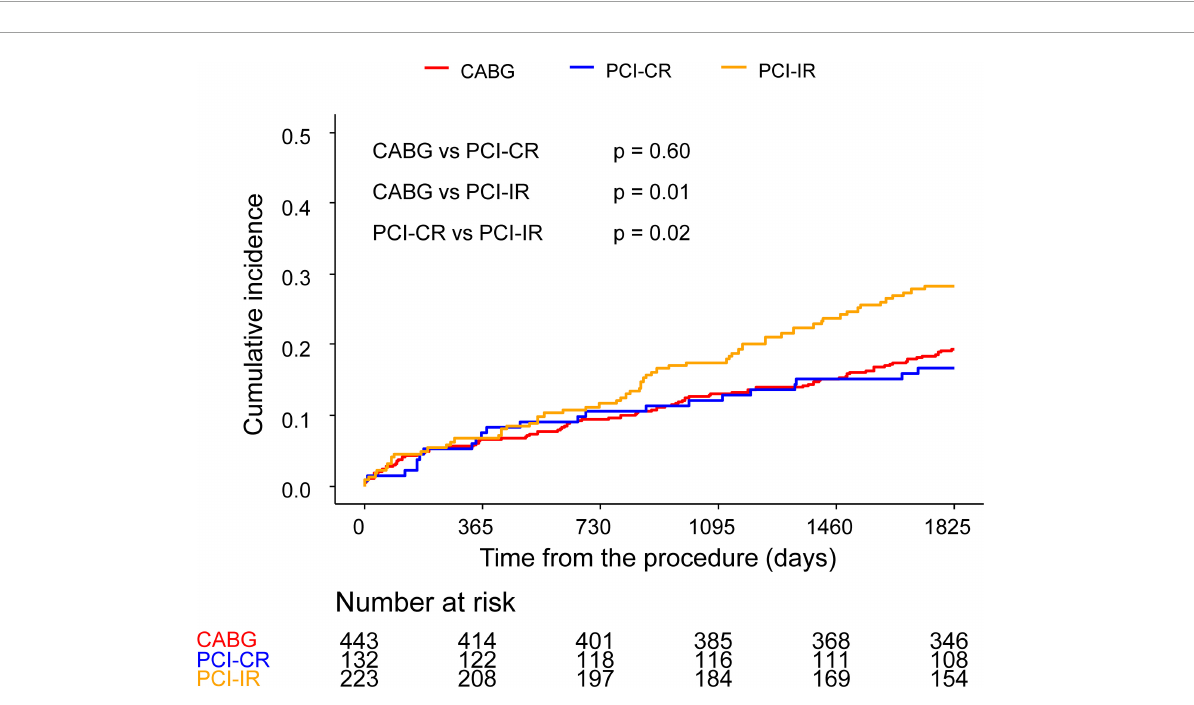
FIGURE4 Comparison of 5-year MACCE among the CABG, PCI-CR, and PCI-IR groups. Kaplan–Meier curves comparing MACCE at 5 years among the CABG and two PCI groups. CABG, coronary artery bypass graft; PCI, percutaneous coronary intervention; MACCE, major adverse cardiac and cerebrovascular